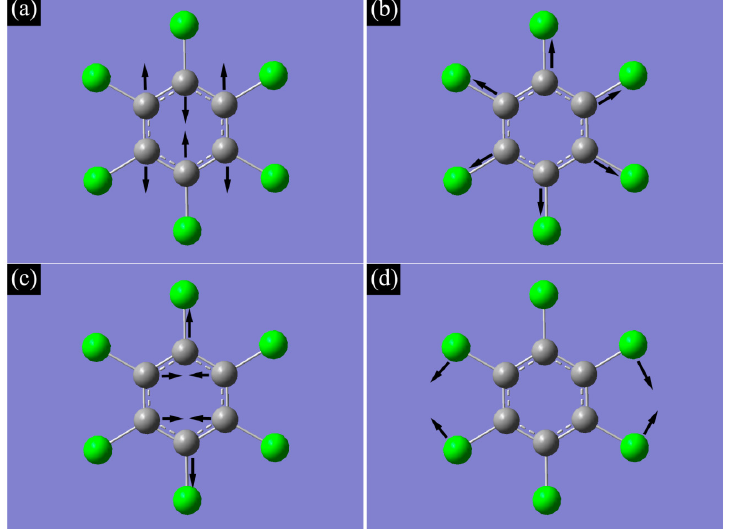
Figure 3. Illustration of vibration in hexachlorobenzene for: (a) CCC stretching vibration mode; (b) benzene ring breathing vibration mode; (c) CCC deformation in plane vibration mode; (d) C-Cl shear vibration